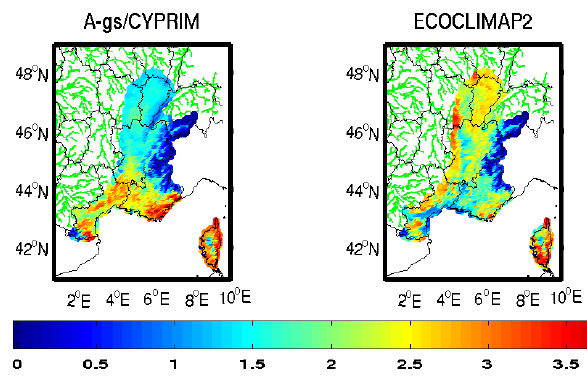
Figure 4: Springtime LAI averaged over 1970-2000 for the A-gs version of ISBA with 2 Fig. 4. Springtime LAI averaged over 1970–2000 for the A-gs ver- CYPRIM climate forcing (A-gs/CYPRIM), and for the ECOCLIMAP2 database. 3 sion of ISBA with CYPRIM climate forcing (A-gs/CYPRIM), and 4 for the ECOCLIMAP2